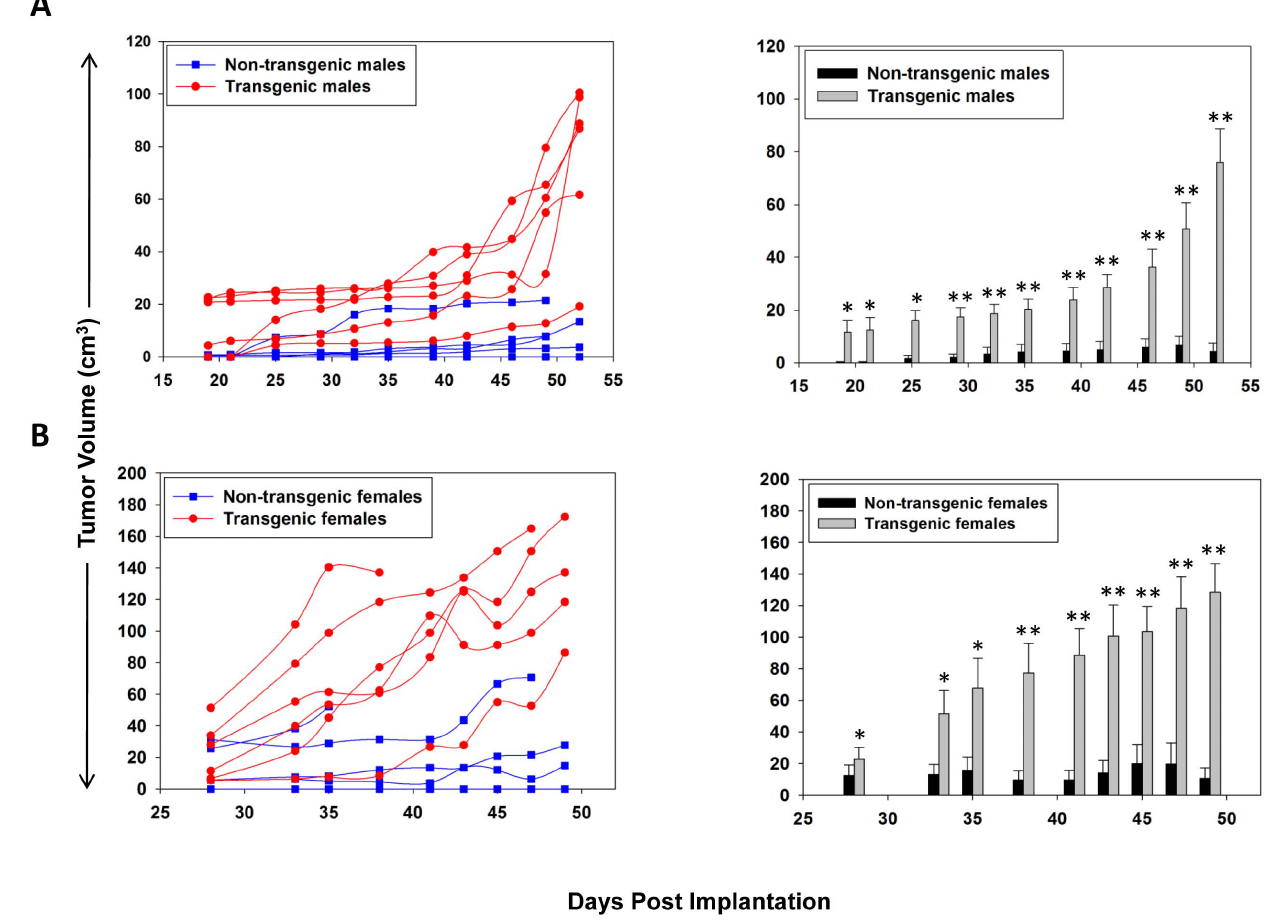
Figure 1. Invivo tumor-promoting potential of b hCG. SP2/O cells were implanted in BALB/c x FVB/J b hCG/- F1 transgenic and non- transgenic male (A) and female (B) mice. Left panels depict tumor volumes in individual animals and right panels mean 6 standard error, at different times post-cell implantation. *p # 0.05; **p # 0.01 versus non-transgenic littermates. n=6.